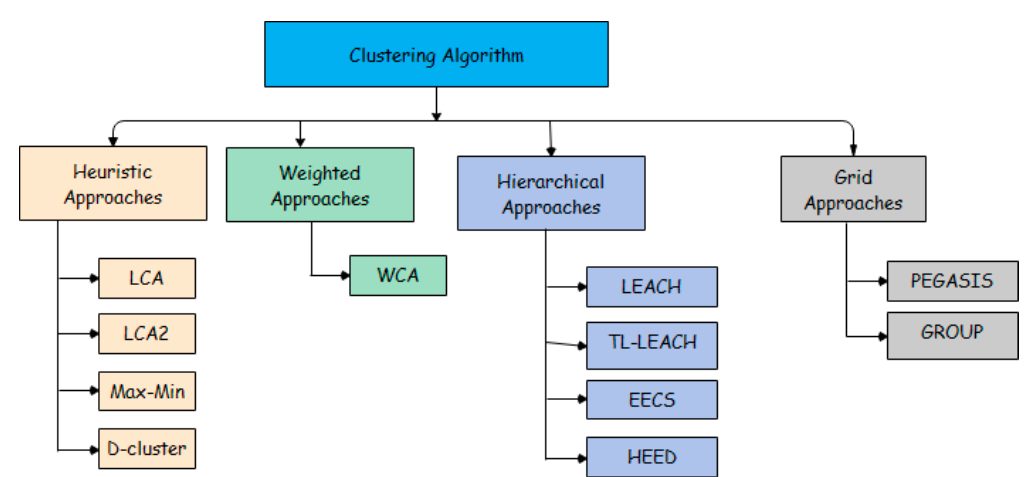
Figure 5. Classification of earlier clustering algorithms.